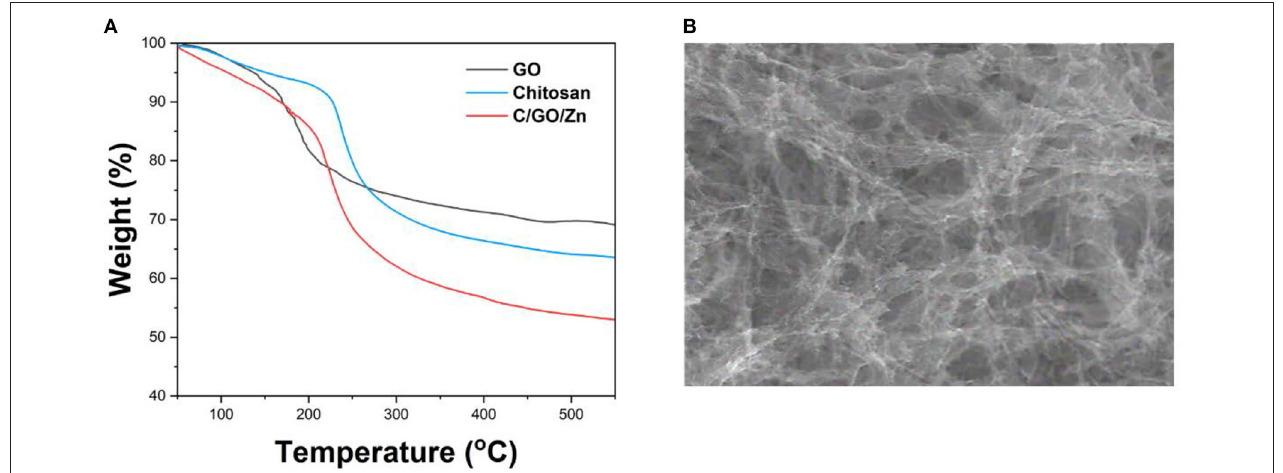
FIGURE 2 | (A) TGA curves of GO, chitosan, and C/GO/Zn. (B) SEM image of C/GO/Zn.